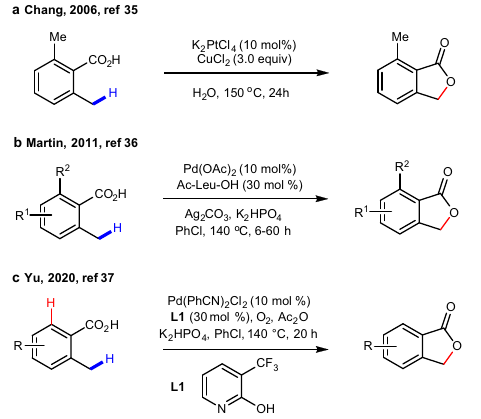
Fig. 1 Transition metal-catalyzed direct C – H lactonization reactions. a Pt- catalyzed lactonization reported by Lee and Chang 35 ; b Pd-catalyzed, MPAA ligand and Ag salt-assisted, lactonization by Novák et al. 36 , and c Pd-catalyzed, pyridine ligand and O 2 -assisted lactonization by Qian et al. 37 . NATURE COMMUNICATIONS| (2022) 13:315